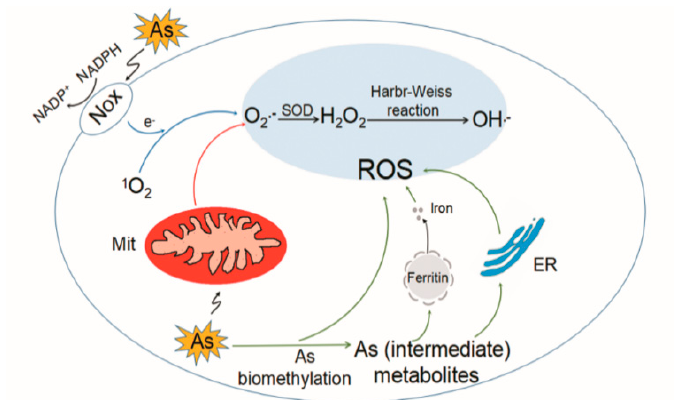
Figure 1. Mechanisms of generation of reactive oxygen species (ROS) induced by arsenic. Arsenic (As) induces significant ROS generation mainly through the mitochondrial (Mit) electron transport chain. Activation of nicotine adenine disphosphonucleotide (NADPH) oxidase (Nox) also contributes to the generation of superoxide anion (O 2 − • ). Additionally, arsenic metabolism leads to the generation of ROS in cells. 1 O 2 , singlet oxygen; H 2 O 2 , hydrogen peroxide; • OH, hydroxyl radicals; ER, endoplasmic reticulum; SOD, superoxide dismutase.